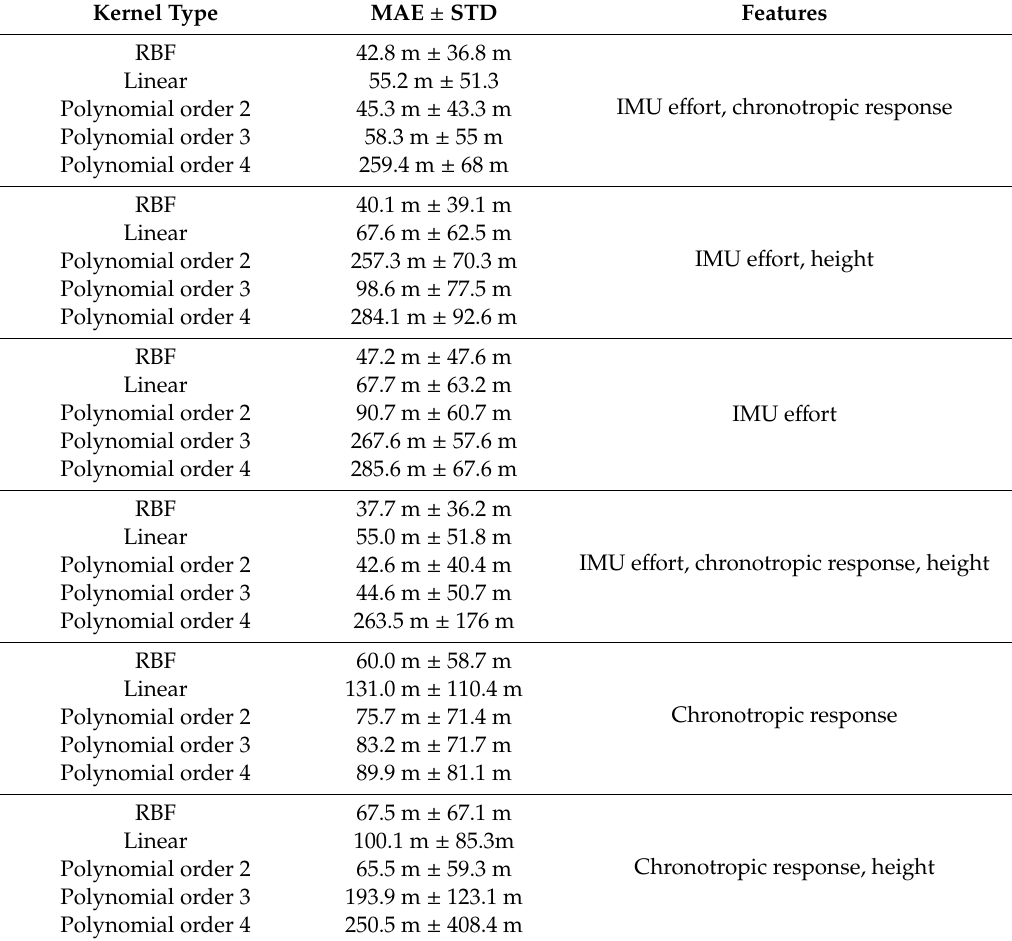
Table 2. Kernel type comparison in support vector machine model.